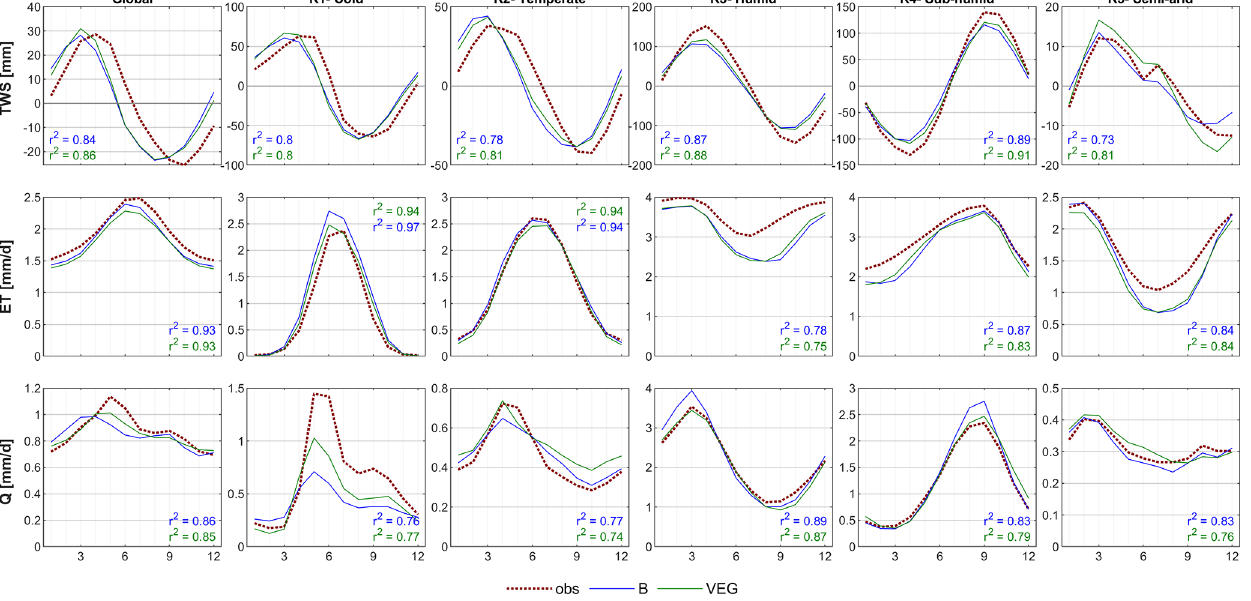
Figure 3. Global and regional mean seasonal cycles of total water storage (TWS), evapotranspiration (ET), and runoff ( Q ) for the B and VEG experiments compared to the observational constraints by GRACE (TWS), FLUXCOM (ET), and GRUN ( Q